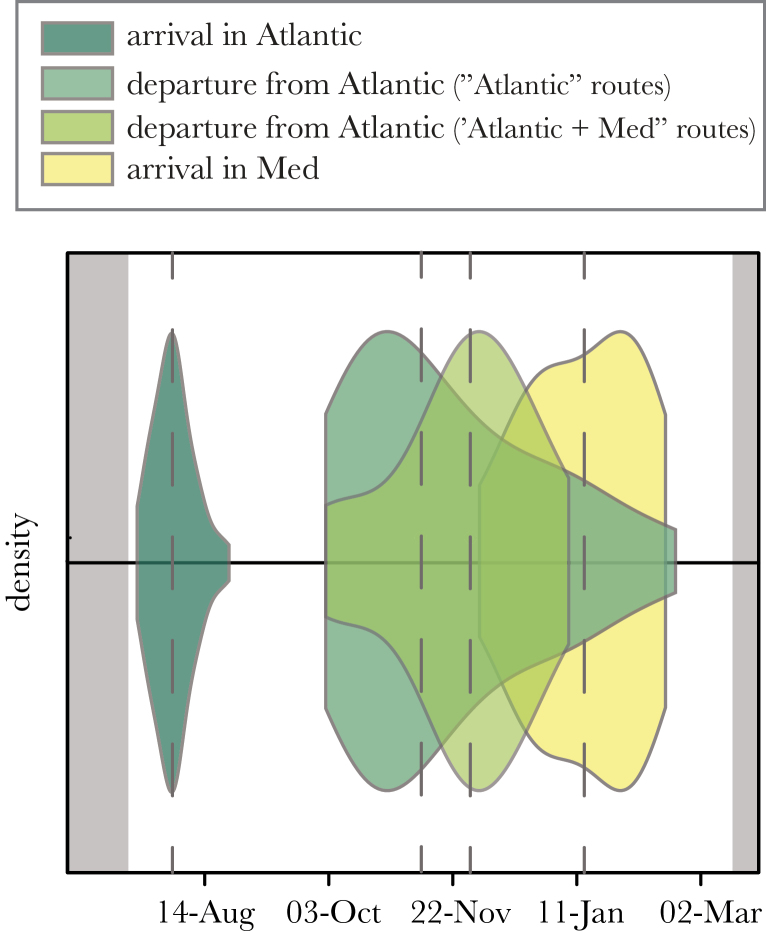
Violin plot representing the timings of migration for puffins with “Atlantic,” “Atlantic + Mediterranean,” or “local + Mediterranean” types of routes (all years pooled). The “local” routes (n = 47) are not represented for lack of major spatial change to describe. Each violin represents the kernel density estimation of birds (normalized) entering or leaving a specific area: entering the Atlantic (crossing the 20° meridian east to west, dark green, n = 61), leaving the Atlantic (crossing the 20° meridian west to east, medium green [“Atlantic” birds, n = 45], and light green [“Atlantic + Mediterranean” birds, n = 16]), or entering the Mediterranean Sea (crossing the Strait of Gibraltar west to east, yellow, n = 16). A narrow violin indicates that all birds depart from or arrive in an area at a similar date. The median date for each movement is indicated with a dashed gray line. The end and start of the breeding season (15 March and 15 July) are in gray.